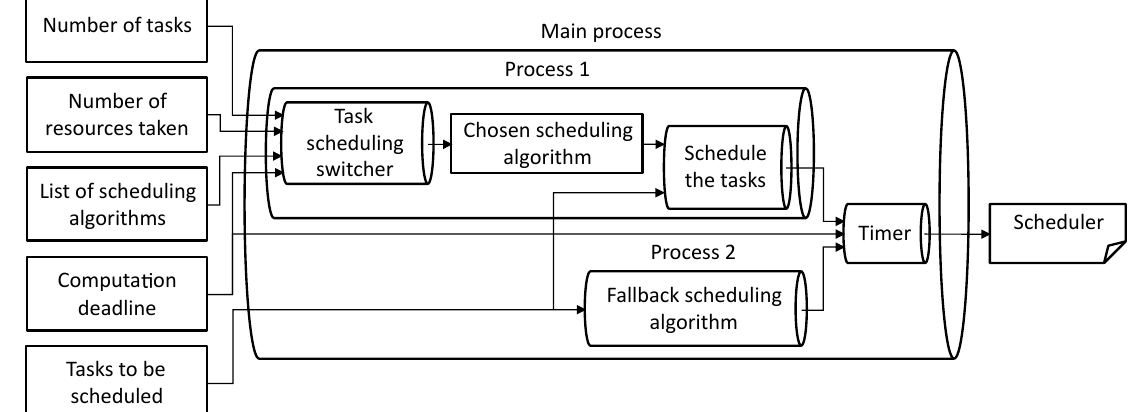
Figure 5. Implementation of the task scheduling switcher on the scheduling